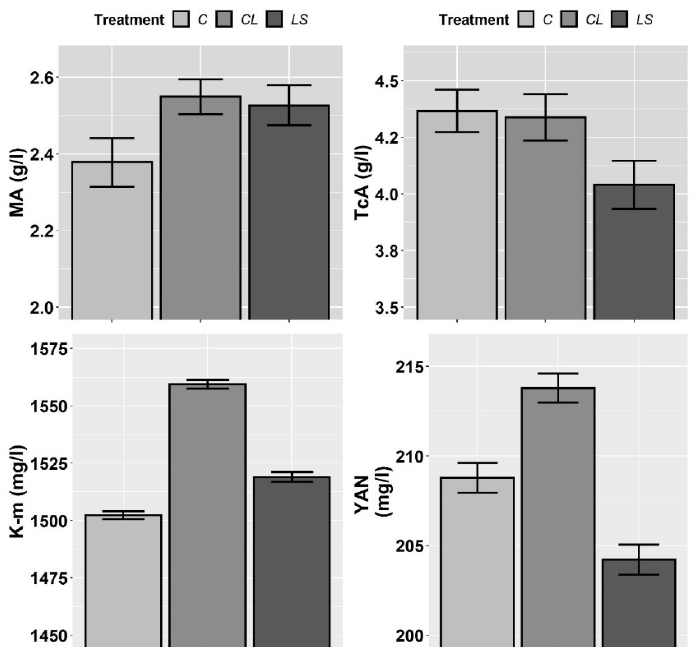
Figure 8. Mean values of the harvest parameters (malic acid (MA), tartaric acid (TcA), must potassium levels (K-m) and yeast assimilable nitrogen (YAN)) for each treatment. Treatments: control (C), control of leonardite (CL), and leonardite mixed with ferrous sulphate heptahydrate (LS). Error bars reflect the SE of the mean (±1 SE mean).